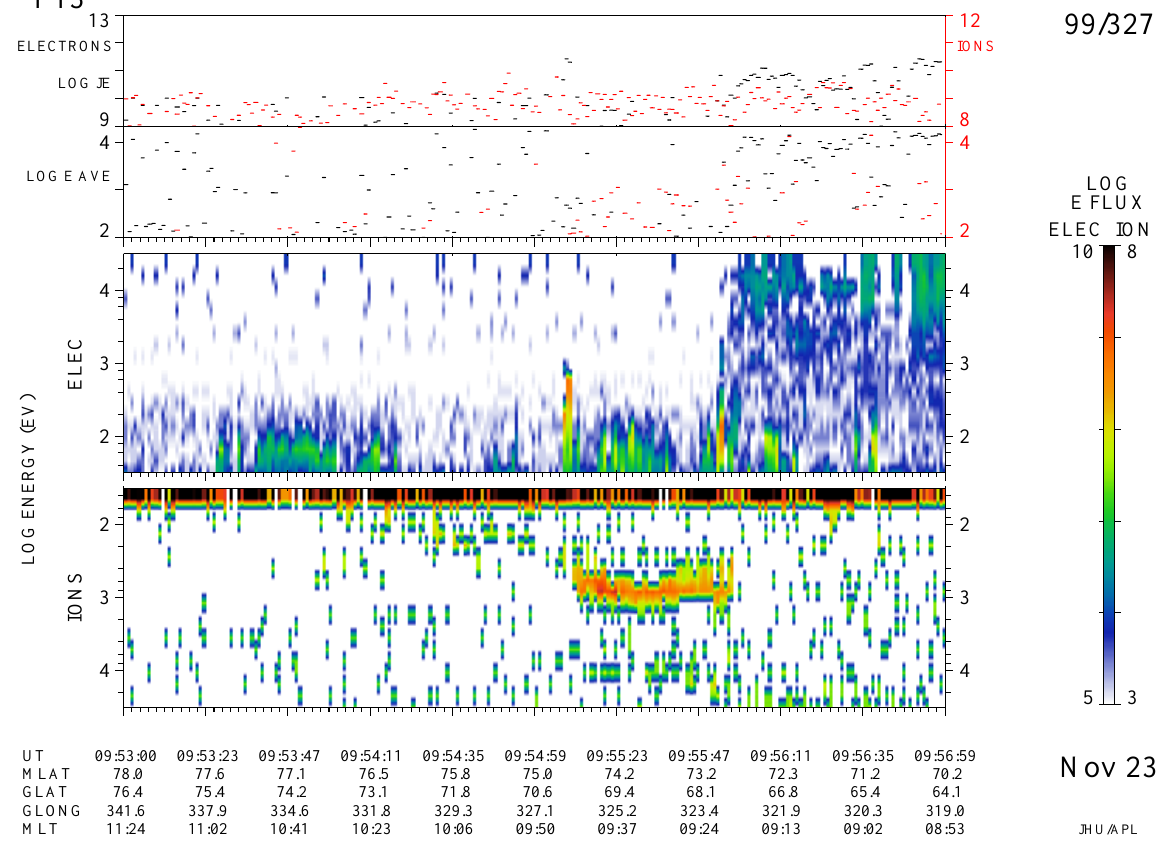
Fig. 8. Same as Fig. 5, showing a dawn pass of DMSP-F13 through the footprint of an adiaroic (non-reconnecting) open-closed boundary near 09:00 MLT. Note that sheath-like precipitation was observed, but ion energies near the open-closed boundary did not exceed